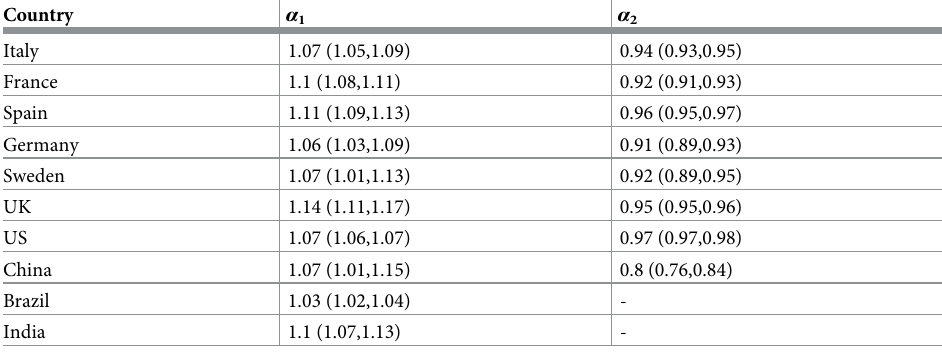
Table 2. Phase 1 versus Phase 2 median and 80% intervals for magnitude parameters, α 1 and α 2 .